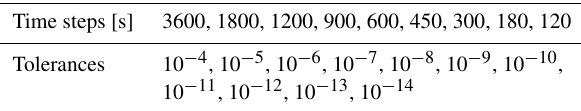
Table 1. Time steps and tolerances used in the numerical experi-